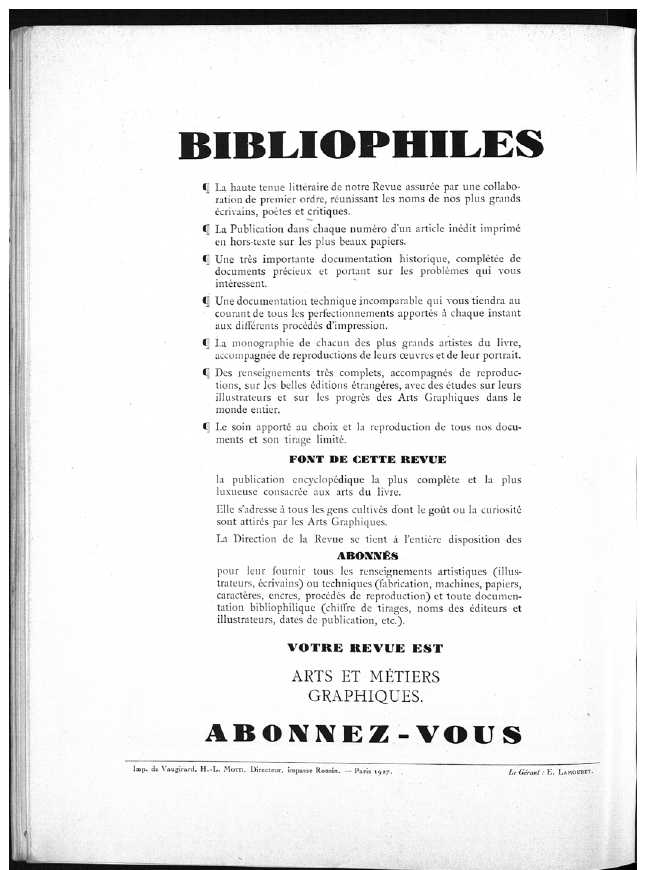
Fig. 4 An advertising leaflet for